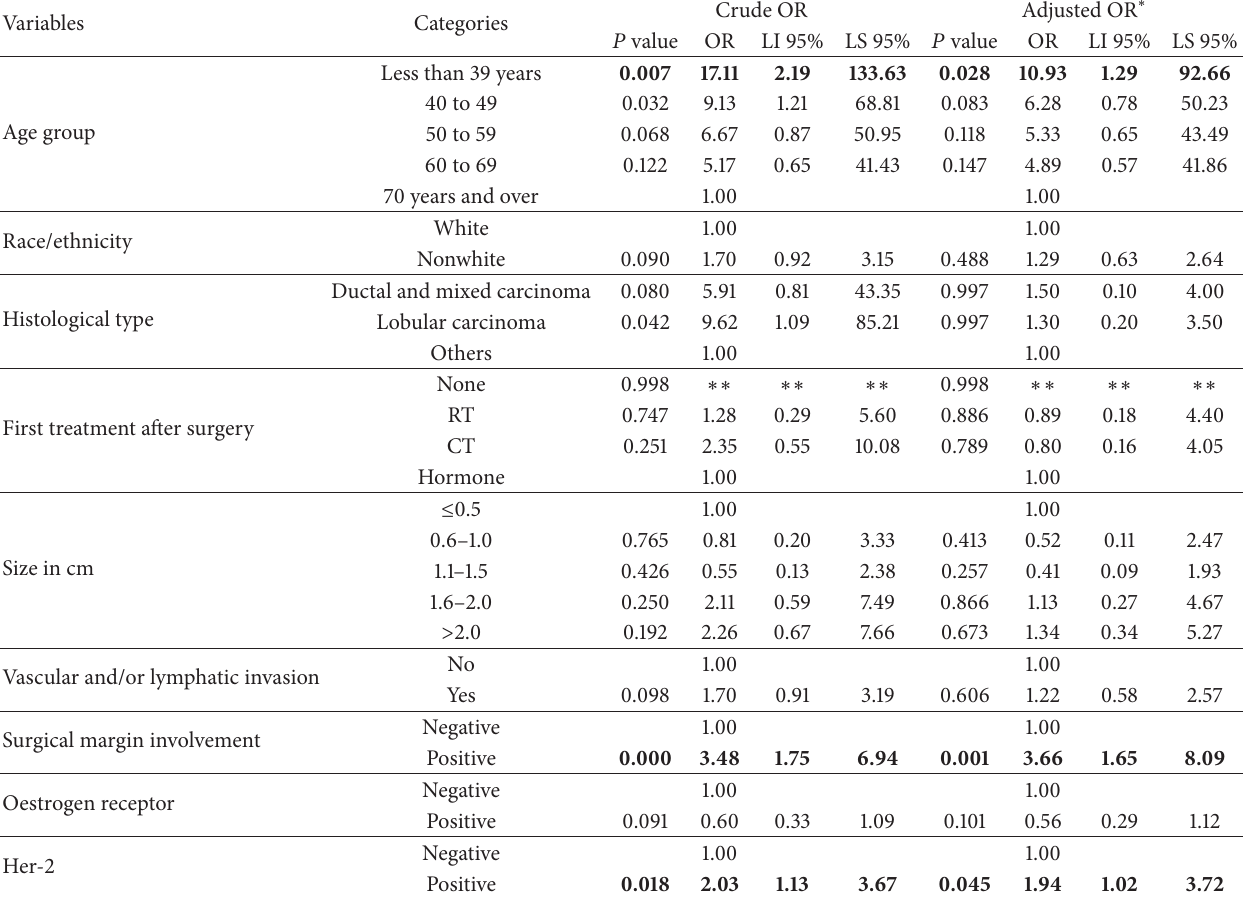
Table 3: Crude and adjusted odds ratios for statistically significant variables in women with breast cancer who underwent breast-conserving surgery and who were registered in HSRC during the period from January 1, 2000 to December 31,